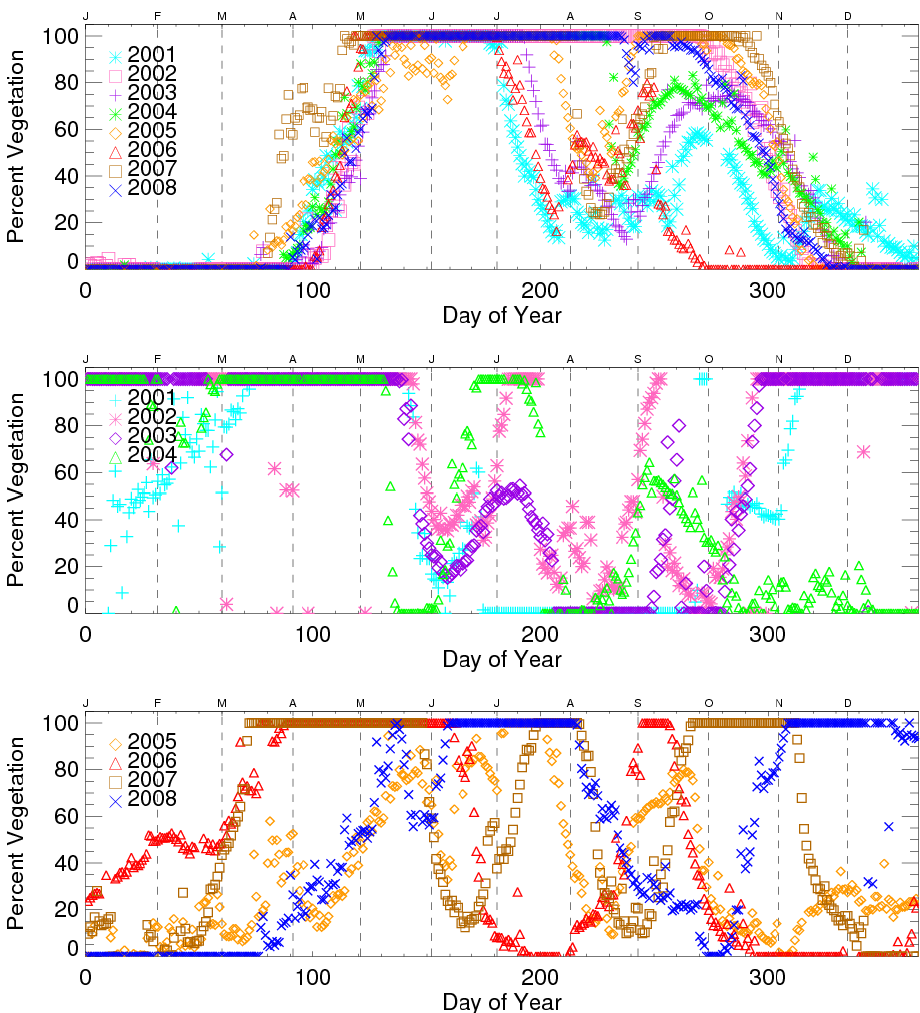
Fig. 4. Time series of daily percent vegetation derived from MFR measurements for (top) 2001–2008 at 10m tower, (middle) 2001–2004 at 25m tower, and (bottom) 2005–2008 at 25m tower. Days with missing data and days classifed as snow are not included in the plots.